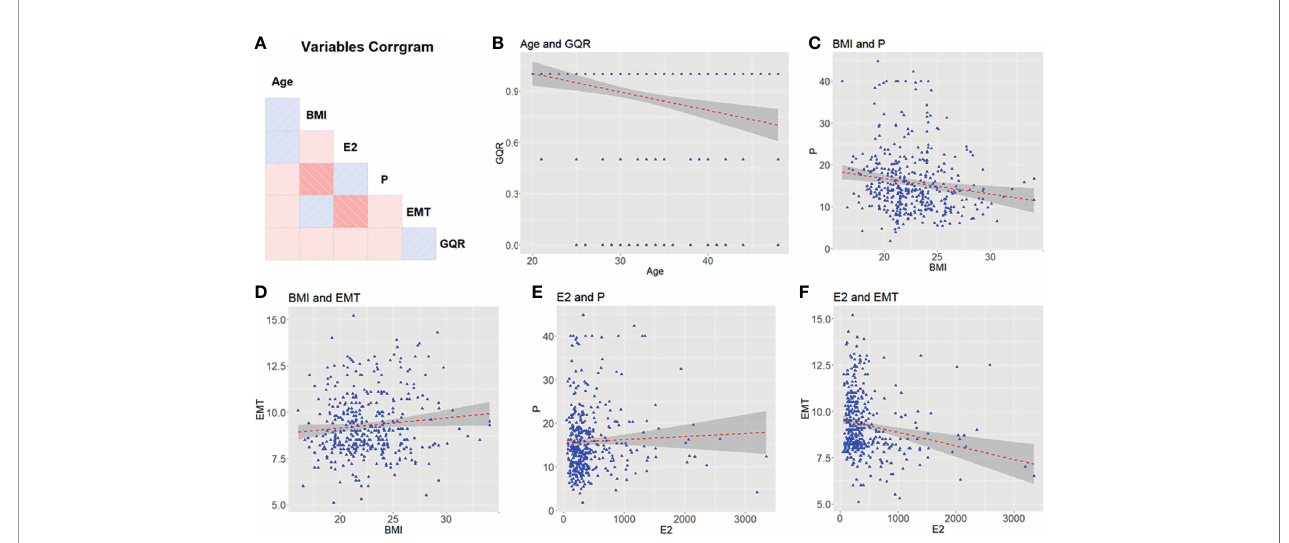
FIGURE 1 | The relationship among clinical characters (age, BMI, E2, P, EMT and GQR) from patients undergoing embryo transfer. (A) Correlation matrix of 6 features. The blue and red squares show positive correlations and negative correlations, respectively. Color depth is positively correlated with correlation coef fi cient. (B – F) Comparison between features. BMI, body mass index; EMT, endometrial thickness on the day of progesterone treatment; GQR, good-quality embryo rate; E2, serum estradiol level on the day of embryo transfer; P, serum progesterone level on the day of embryo transfer.